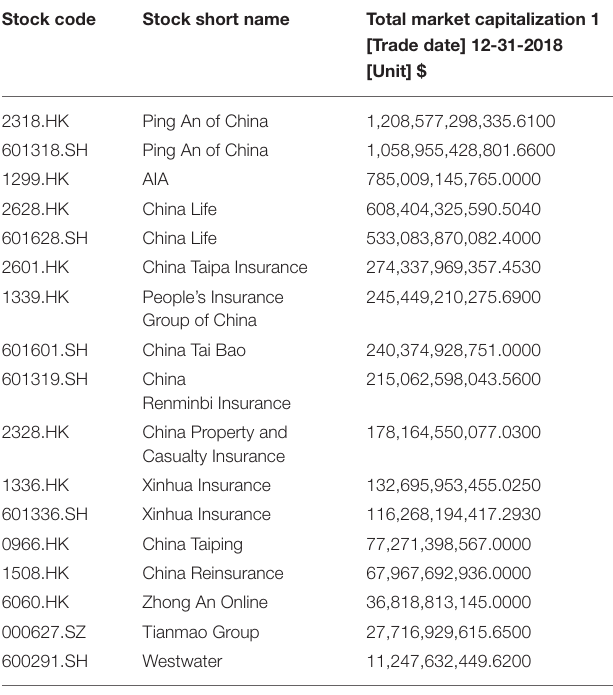
TABLE 2 | Breakdown of the total market capitalization of insurance stocks as of December 31, 2018.